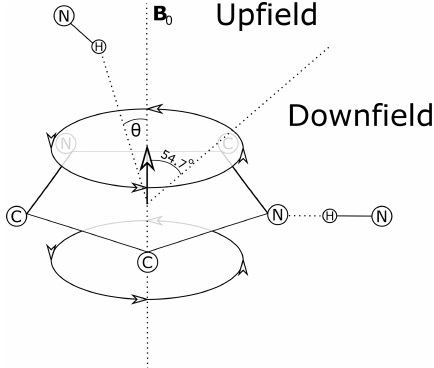
Figure 1. Definition of the azimuthal angle ( θ ) and demarcation of regions of upfield and downfield ring current shifts. For protons above the plane of a Tyr or Phe ring the upfield shift can reach 1.5ppm for distances from the ring center around 3Å; for protons in the plane of the ring the downfield shift approaches 2ppm at 3Å. For Trp the effects can be significantly larger. Local mobility (e.g. fluctuations about the χ 2 sidechain dihedral angle of the aromatic residue) can substantially diminish ring current